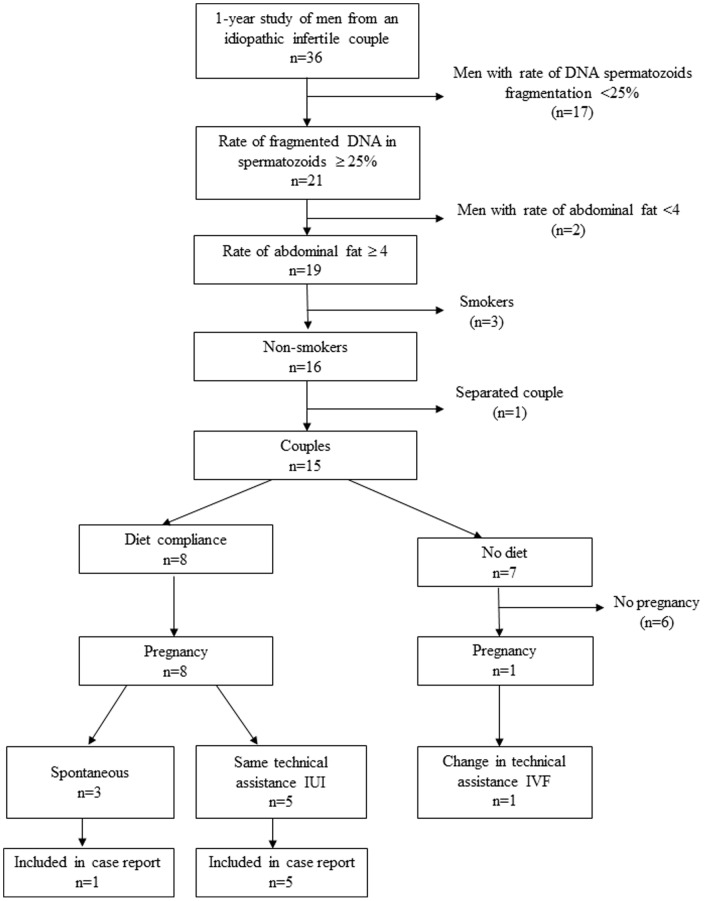
Design of the study.